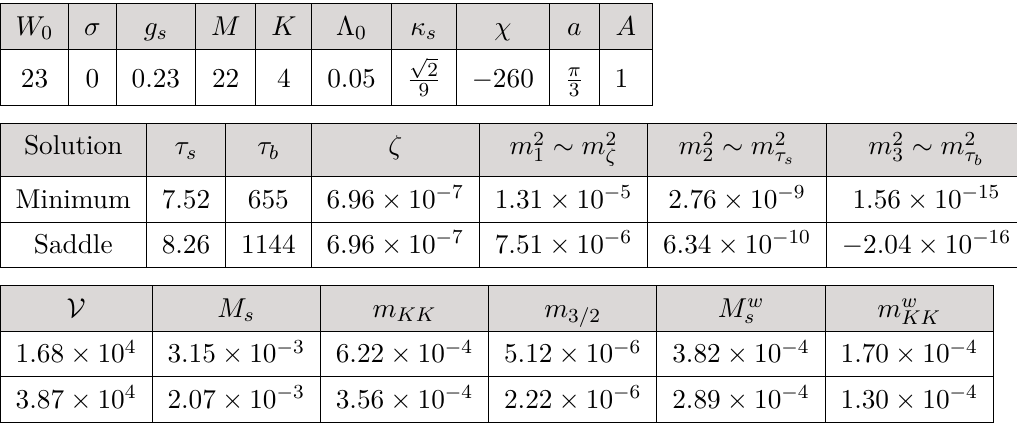
Table 1. Solution and masses for the fields ( τ s , τ b , ζ ) , and physical scales associated with the solution, for a set of parameters with β (cid:28) 1 . The mass scales are expressed in units of M p .